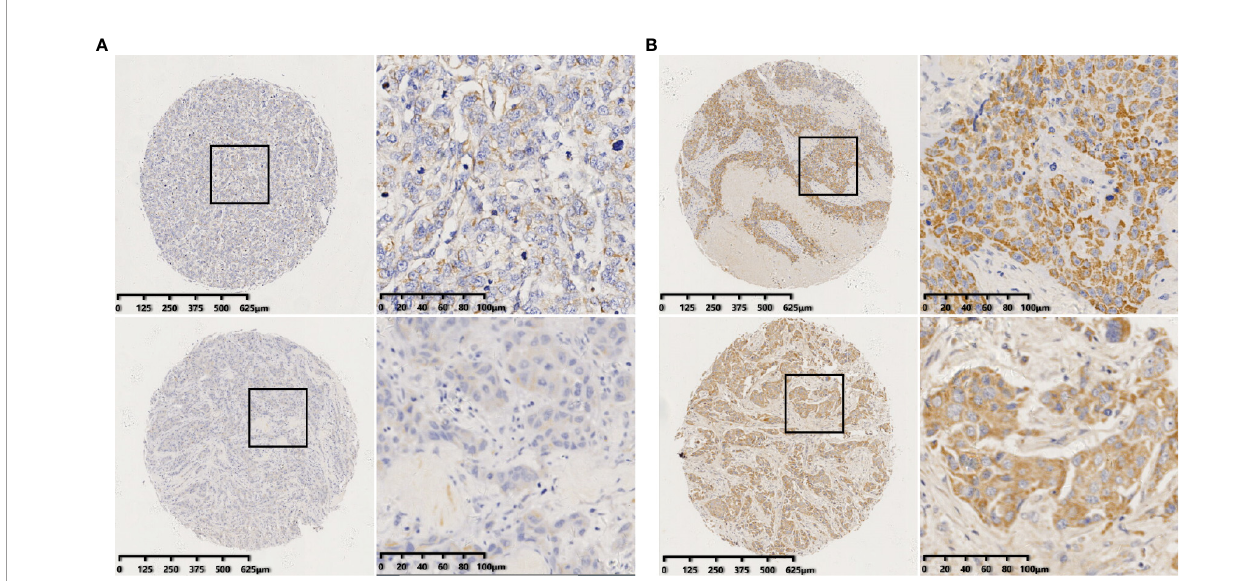
FIGURE 1 | Identi fi cation of miR-223 in breast tumors by in situ hybridization (ISH). (A) Representative staining of negative miR-223 staining (staining index ≤ 4); (B) Representative staining of positive miR-223 staining (staining index >4) (scale bar of low-magni fi cation = 125 m m and scale bar of high-magni fi cation = 20 m